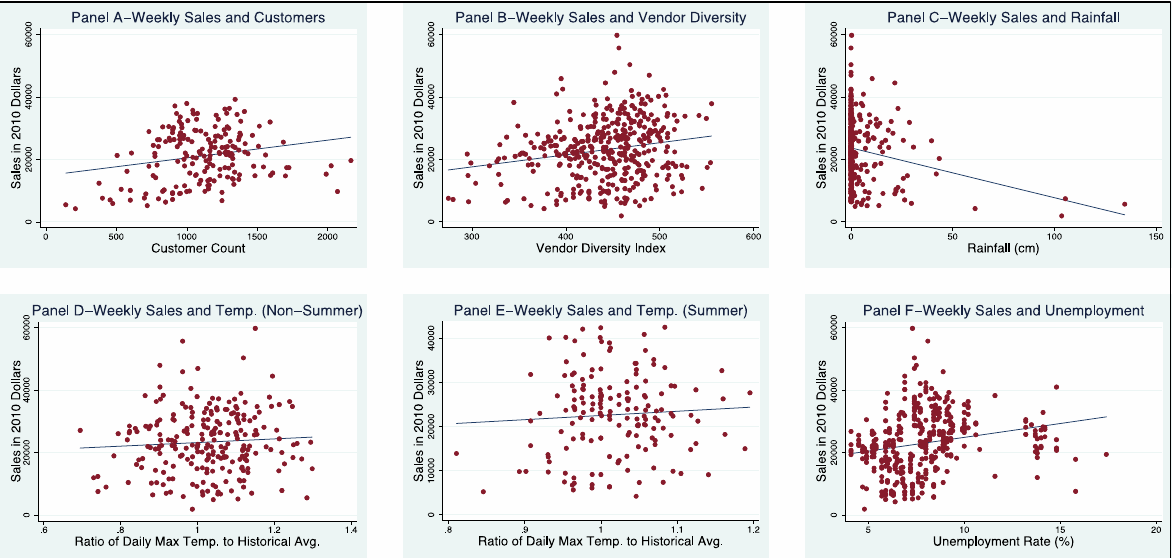
Figure 3. Two-way Graphs Illustrating Data Relationships between Key Explanatory Variables and Weekly Farmers Market Sales, in 2010 Dollars Each graph includes an estimated trend line to better illustrate the